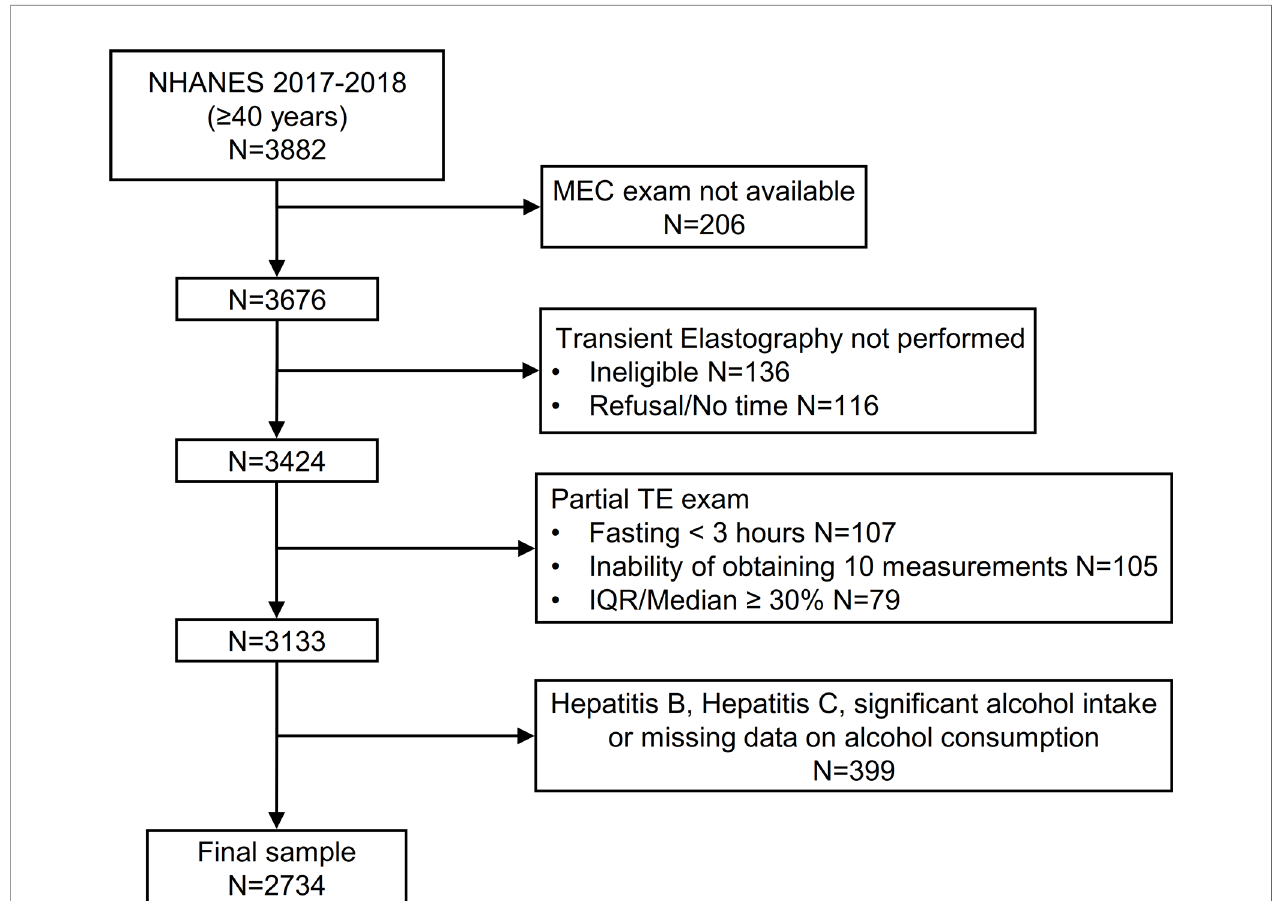
FIGURE 1 | Flow-chart of the study participants. NHANES, National Health and Nutrition Examination